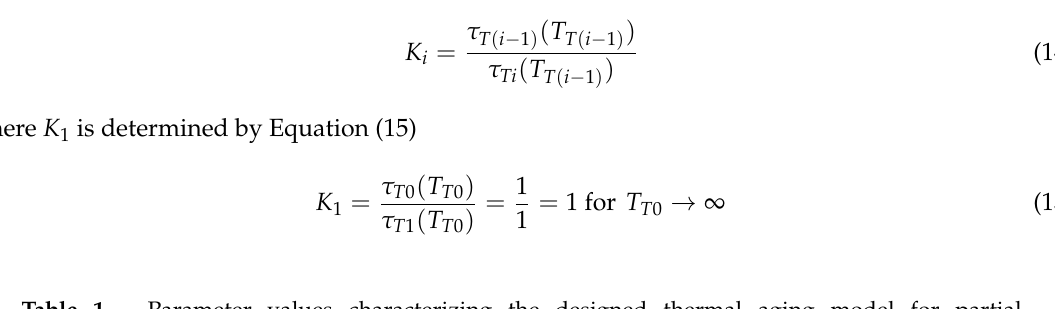
Parameter values characterizing the designed thermal aging model for partial degradation